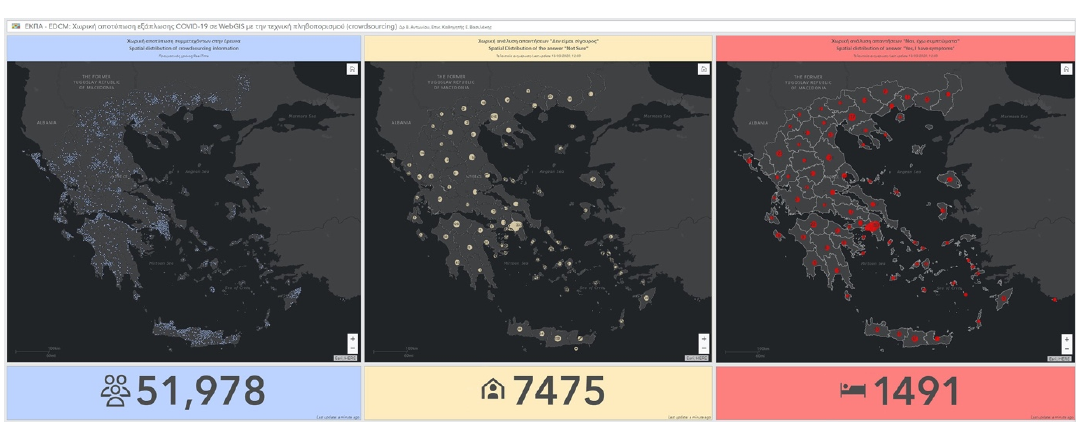
Table 1. Demographic data and official COVID-19 records during the survey (Data Sources: * Hellenic Statistical Authority for 2019, ** https://lab.imedd.org/covid19/). “Other” refers to unclassified cases, or cases located in cruise ships, or refugee camps (COVID-19 data last updated on 16/04/2020).